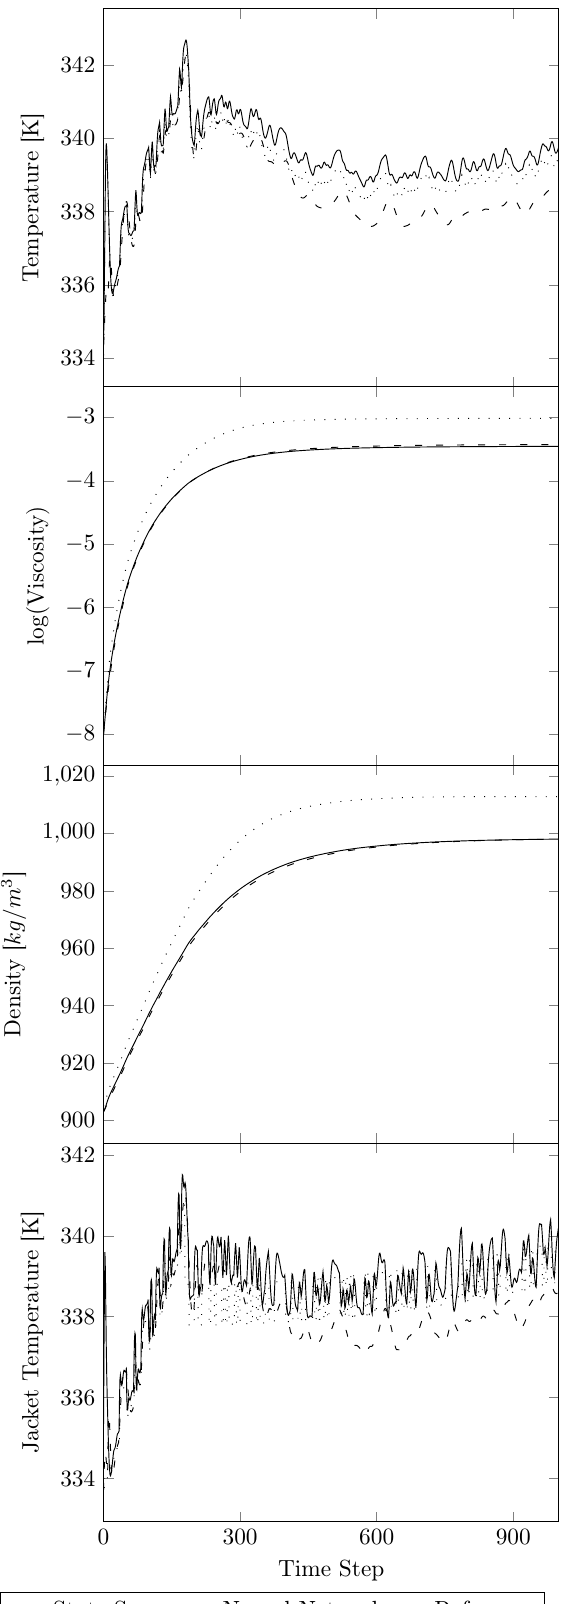
Figure 8. Implementation of state-space models and NARX networks into MPC in the absence of measurement